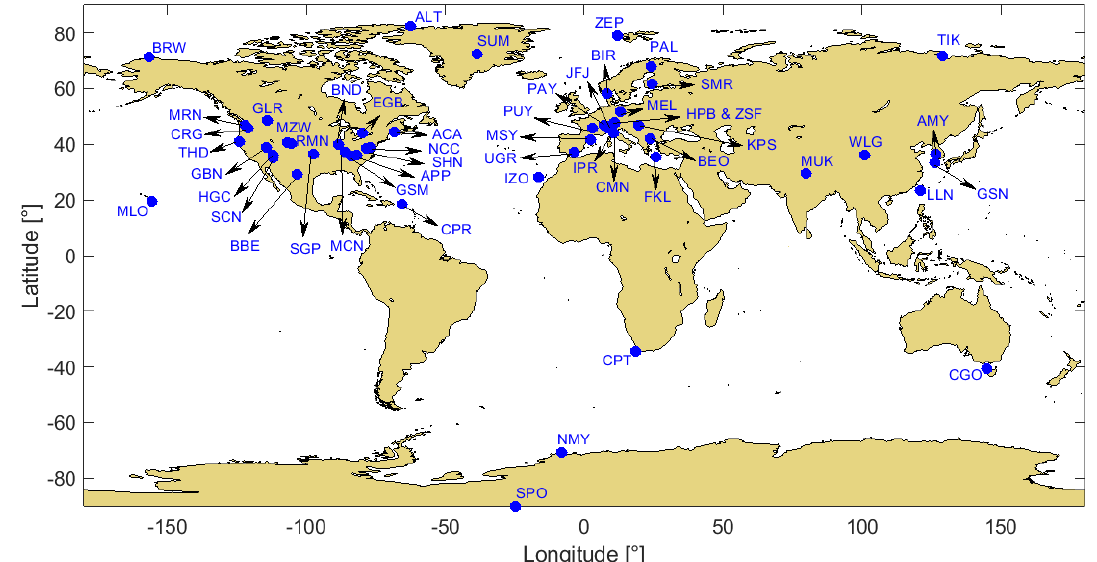
Figure 1. Map of stations with their GAW